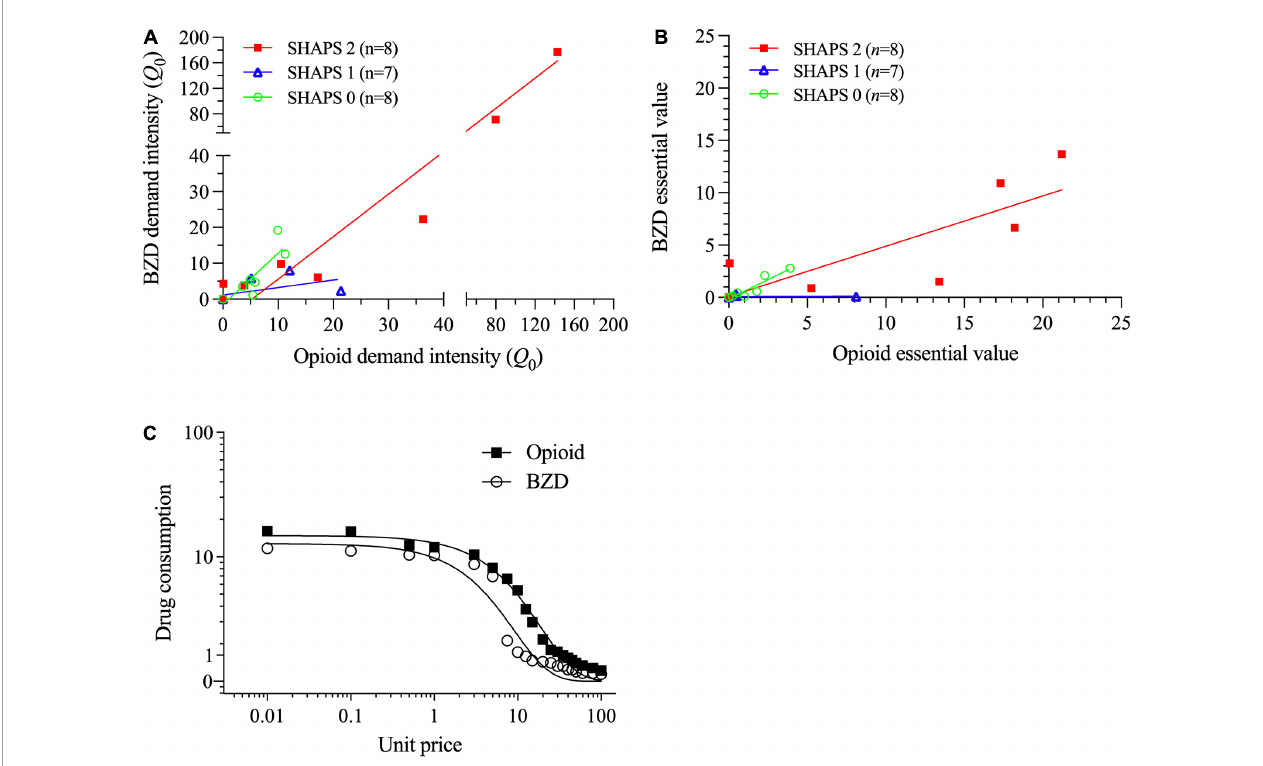
FIGURE4 Within the subgroup of lifetime benzodiazepine (BZD) users, correlations of (A) opioid and benzodiazepine demand intensities (split axes enable better data visualization at low values) and (B) opioid and benzodiazepine essential values. Each of these two panels shows values separately for subgroups with 0, 1 or ≥ 2 Snaith-Hamilton Pleasure Scale (SHAPS) anhedonia scores. (C) In the primary SPSS analysis, opioid essential value (but not demand intensity) was significantly greater for the preferred-opioid than alprazolam (see Section “3.2. Aim 2: Differences within lifetime BZD-misusing subgroups”). In the secondary GraphPad Prism analysis, the preferred-opioid and alprazolam curves significantly differed ( Q 0 = 18.7 vs. 11.6; EV = 4.83 vs. 1.03), F (1,18) = 68.0, p <